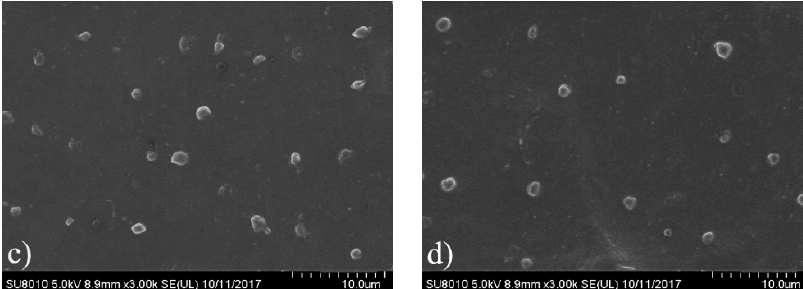
Figure 11. Representative SEM micrographs of platelet adhesion on the surface of ( a ) CPU-1.0; ( b ) CPU-1.4; ( c ) CPU-1.7 and ( d ) CPU-2.0 films.